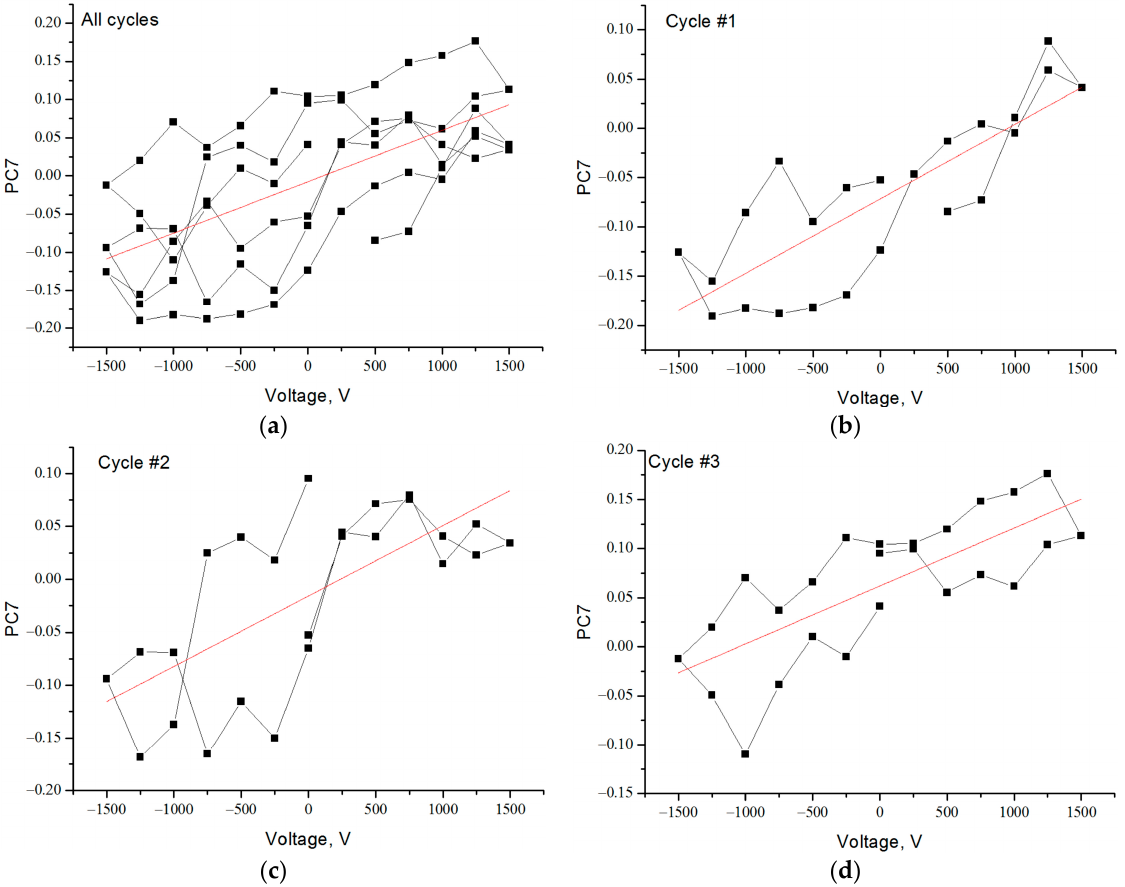
Figure 3. Correlation factor r for various principal components.